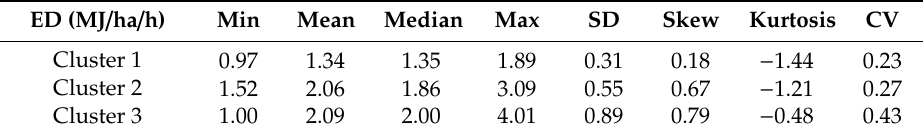
Table 4. Statistical properties of the mean monthly ED values of the clusters (centers of the clusters). SD is an abbreviation for standard deviation and CV for coe ffi cient of variation.